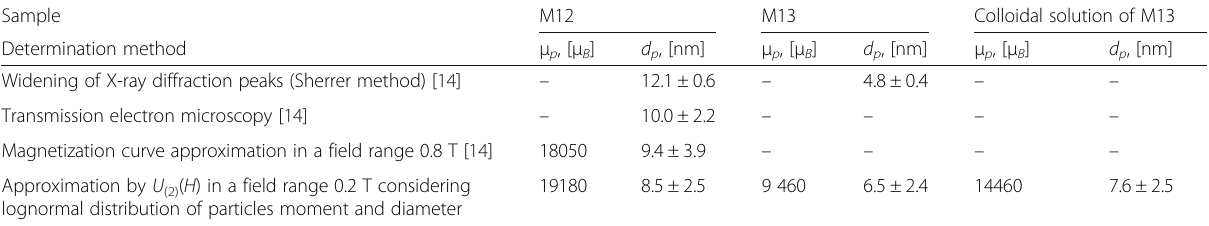
methods: XRD, TEM, as well as with results of approxi- mation of sample magnetization dependence measured by VSM in the field range 0.8 T [14]. Average values in the last row are shown together with deviation. The average values and deviations were found by (8). Charac- teristic feature of the nonlinear magnetic susceptibility dependency on the applied field as we can see is that all changes are concentrated in the narrow field range. In particular, saturation of the dependency is observed already at a field 0.2 T while corresponding changes in magnetization curve require much wider field range. Table 1 Results of determination of average magnetic moment and diameter of investigated nanoparticles M12, M13 and colloidal solution of M13 by different methods Sample M12 Determination method